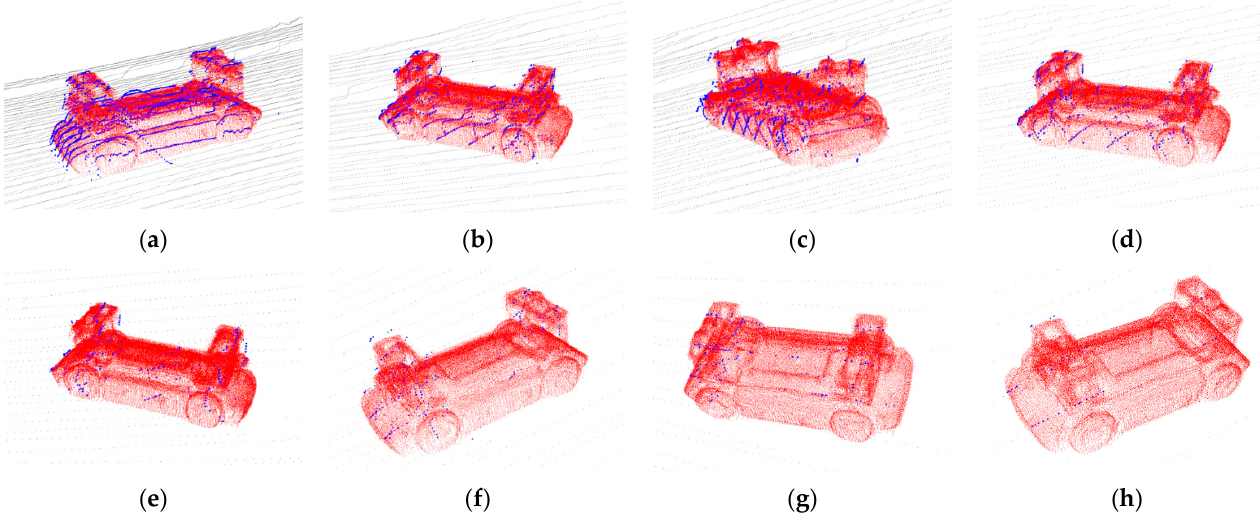
Figure 17. Typical pose estimation results in the real test environment. Blue points represent the clustered point cloud. Black points represent the background points, and red ones represent estimated pose results. ( a ) 𝑺′ = 22.65 ; ( b ) 𝑺′ = 15.62 ; ( c ) 𝑺′ = 12.58 ; ( d ) 𝑺′ = 8.5 ; ( e ) 𝑺′ = 4.4 ; ( f ) 𝑺′ = 4.67 ; ( g ) 𝑺′ = 4.2 ; ( h ) 𝑺′ = 2.8 .